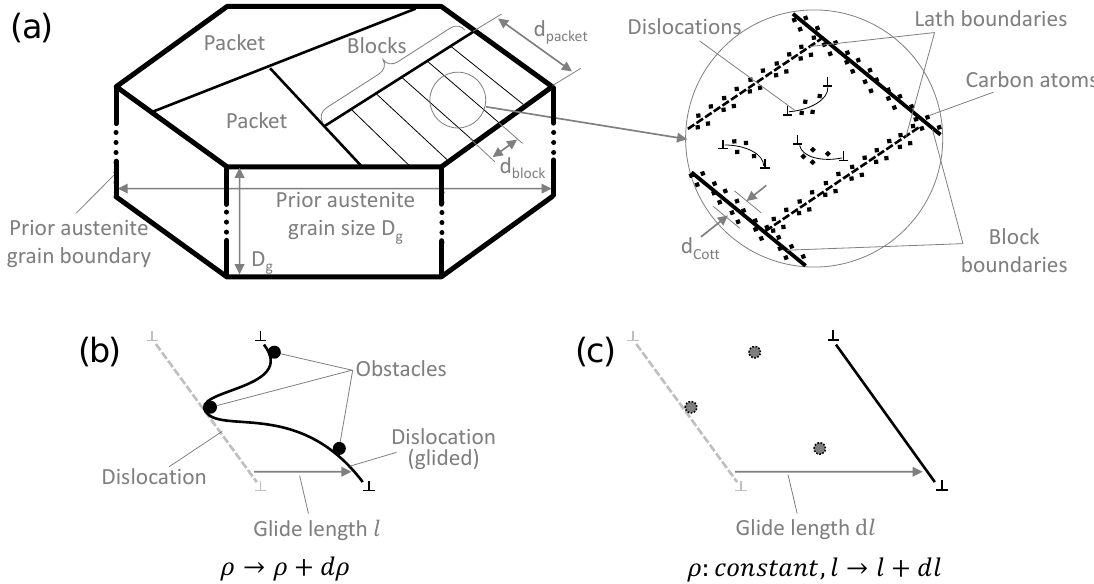
Figure 1. ( a ) Multi layered structure and interior of martensite. Schematic images of ( b ) dislocation density increase by pinning obstacles and ( c ) increase in glide distance at a constant dislocation